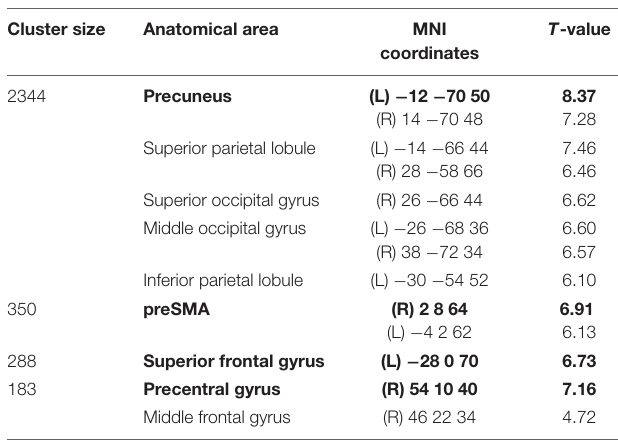
TABLE 2 | Cerebral regions showing significant increases in activity in FL with respect to SL ( p < 0.05, FWE corrected at cluster-level -voxel defining threshold p <